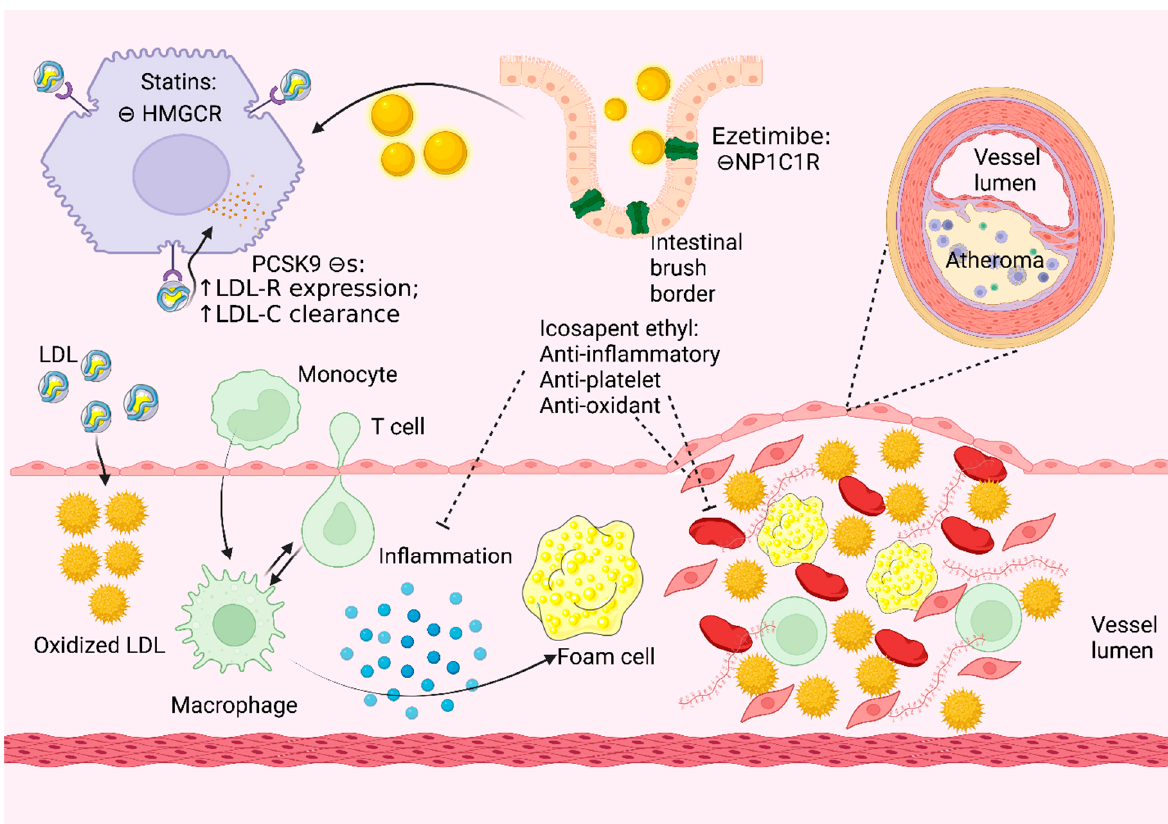
Figure 2. Role of oxidized lipoproteins in the development of atherosclerosis, with specific targets and mechanism of action of statins, ezetimibe, and PCSK9 inhibitors. HMGCR: 3- β -Hydroxy β - methylglutaryl-CoA reductase, LDL: Low-density lipoprotein, LDL-C: Low-density lipoprotein cholesterol, LDL-R: Low-density lipoprotein receptor, NP1C1R: Niemann–Pick C1-like 1 receptor, PCSK9: Proprotein Convertase Subtilisin/Kexin Type 9.